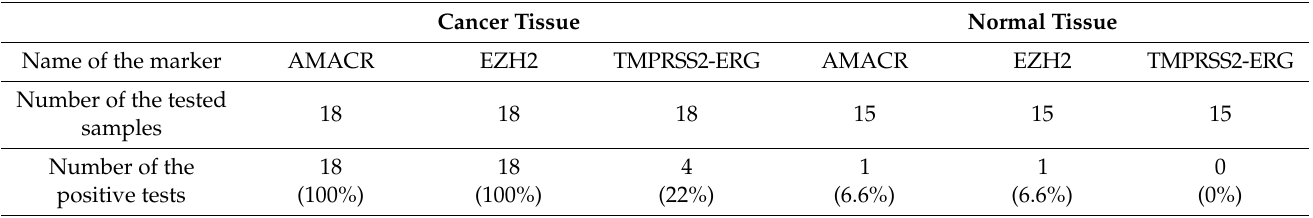
Table 1. Expression of AMACR, EZH2, and TMPRSS2-ERG in the cancerous and normal prostate tissues and early